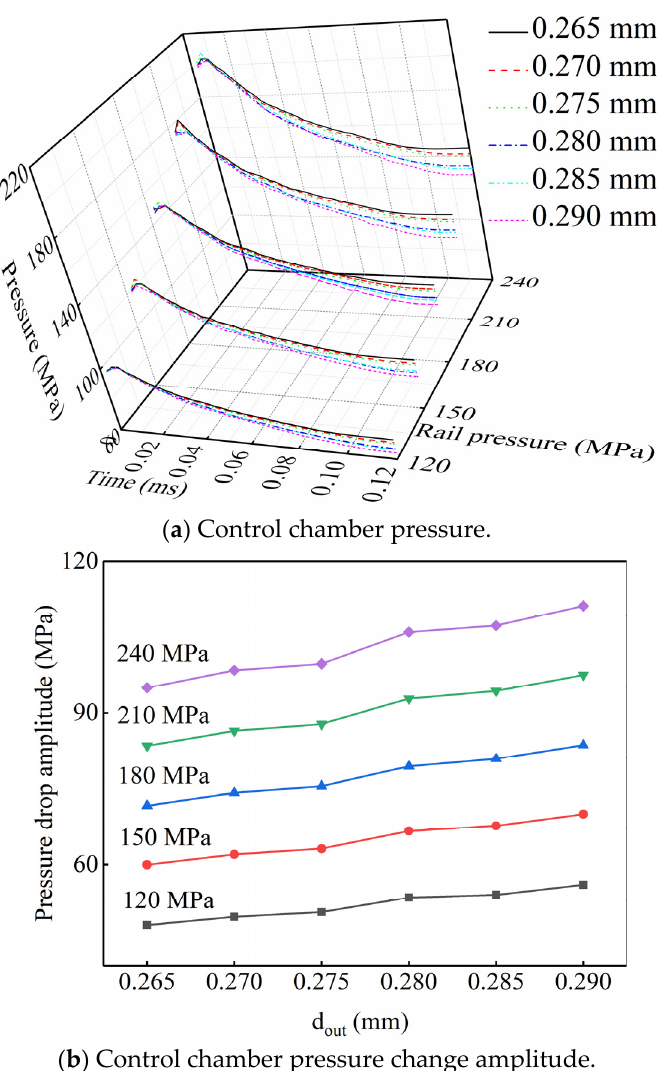
Figure 16. The influence law of the deviation of rail pressure and outlet throttle diameter on the control chamber pressure coupling.